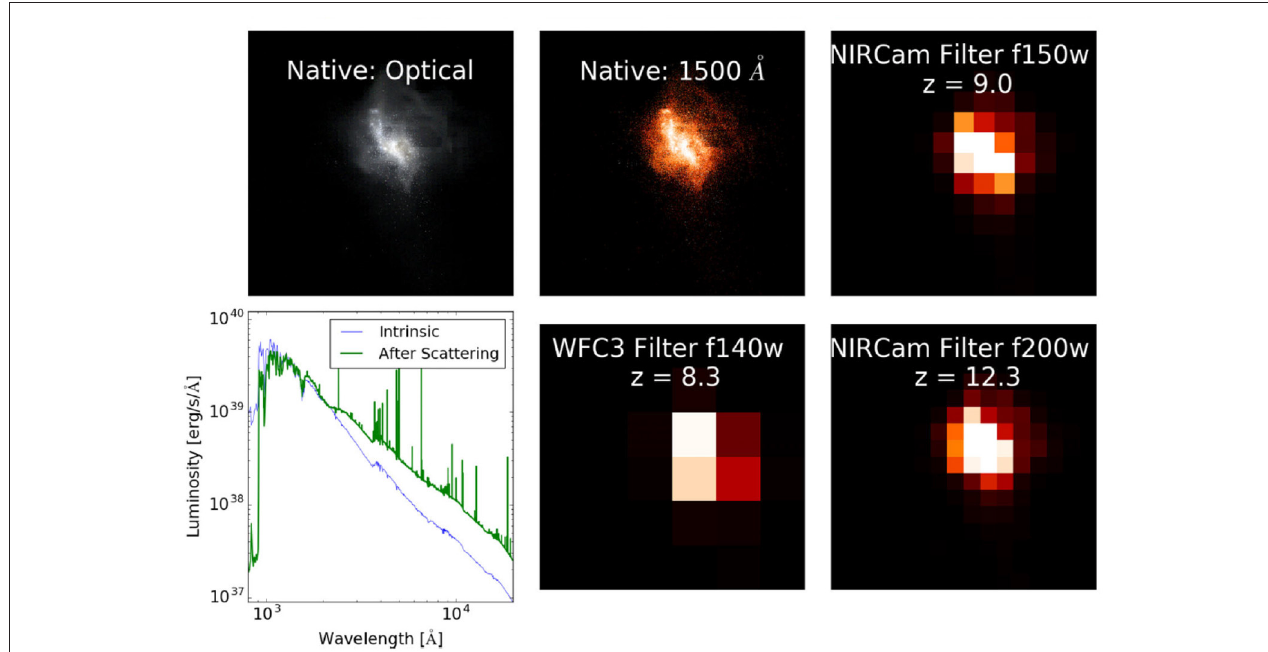
FIGURE 1 | A simulated z = 15 high redshift protogalaxy and its photometric appearance with Hubble Space Telescope and the James Webb Space Telescope. A partial reproduction of Figure 12 from Barrow et al.